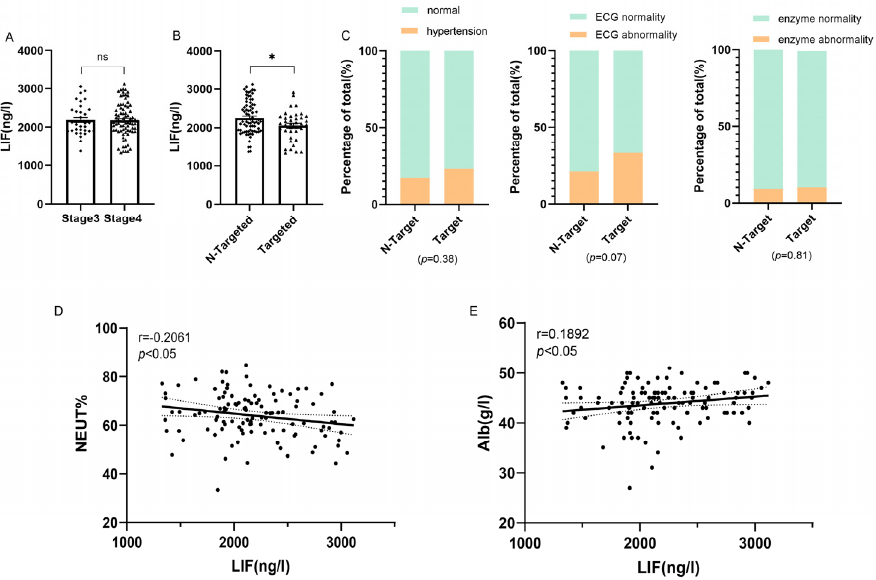
Figure 1. Correlation between serum leukemia inhibitory factor (LIF) levels and clinical features.